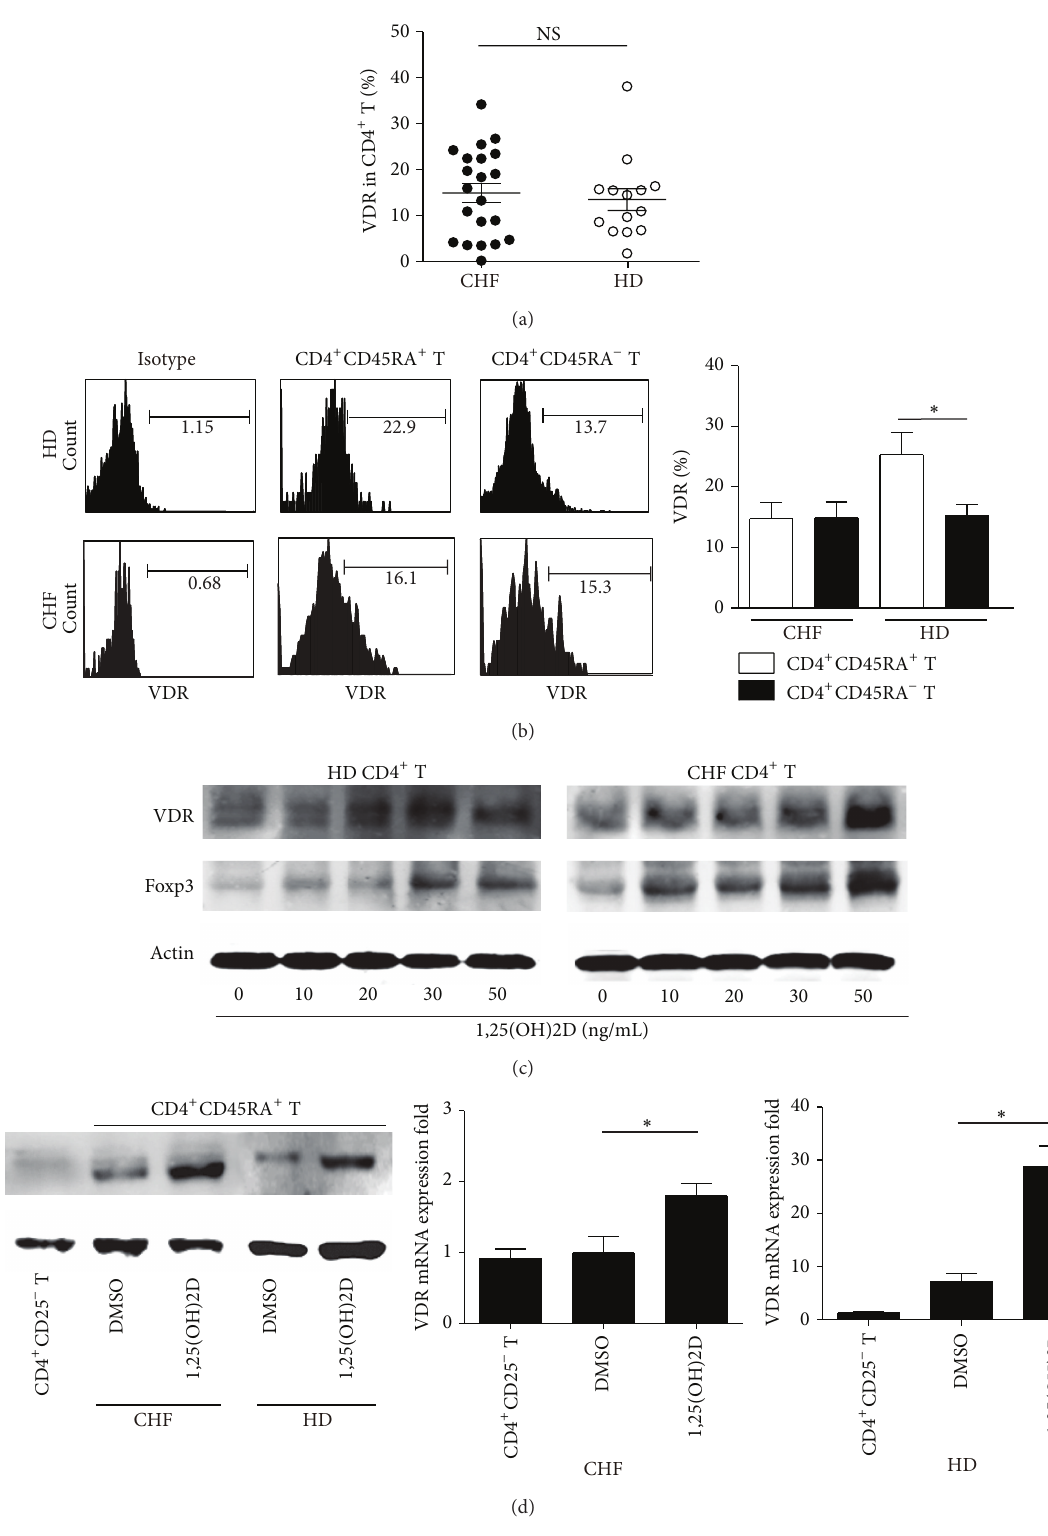
Figure 6: 1,25(OH)2D induced CD4 + CD45RA + T cells prohibited CD4 + CD25 − T effector cells via upregulated VDR. VDR expression in CD4 + T (a) or in CD4 + CD45RA + T and CD4 + CD45RA − T cells (b) was measured by FACS PBL from PBL of HD and CHF. (c) CD4 + T cells were isolated by MACS and then incubated with a series of concentrations of 1,25(OH)2D for 5 days. VDR and Foxp3 expression in induced cells was measured by WB. (d) CD4 + CD45RA + T cells were isolated by MACS and incubated with 1,25(OH)2D or DMSO for 5 days. VDR expression was measured by WB and real-time